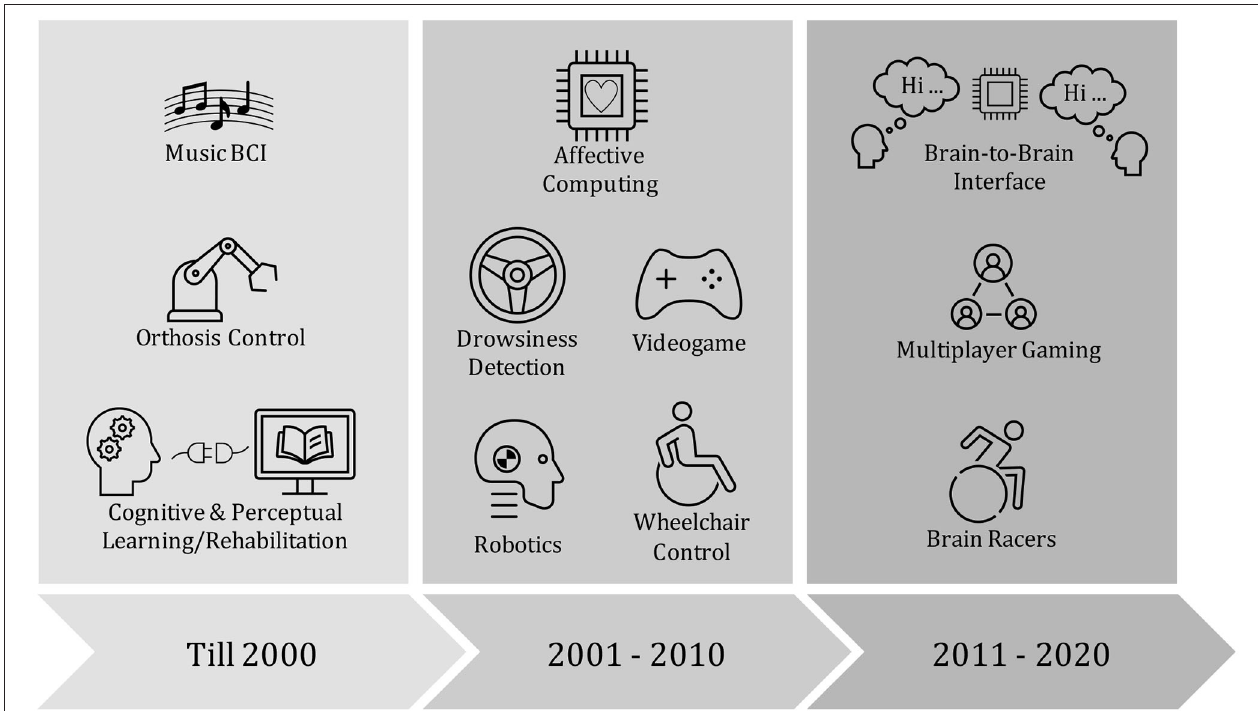
FIGURE 2 | A schematic illustration of the evolution of the brain computer interface (BCI) applications: Cognitive & Perceptual Learning/Rehabilitation (McMillan et al., 1995); Orthosis Control (Pfurtscheller et al., 2000); Music BCI (Rosenboom, 2014); Robotics (Millan et al., 2004); Wheelchair Control (Iturrate et al., 2009); Drowsiness Detection (Lin et al., 2008); Affective Computing (Zander et al., 2009); Brain Racers (Perdikis et al., 2017); Multiplayer Gaming (Nijholt and Poel, 2016); Brain-to-Brain Interface (Rao et al.,